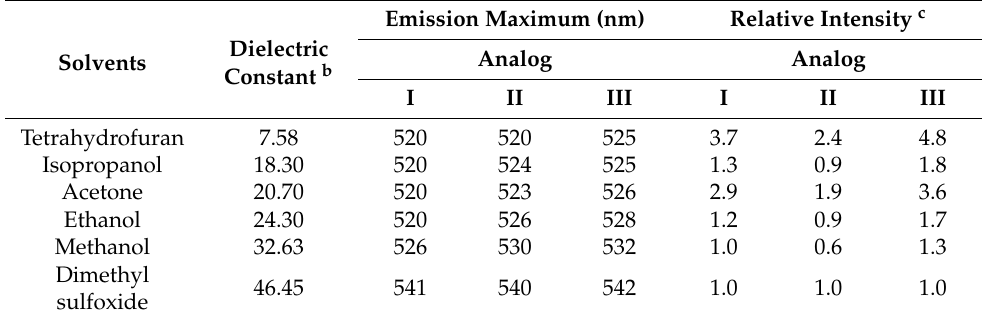
Table 2. Solvent effects on the fluorescence characteristics of NBD-labeled serotonin analogs